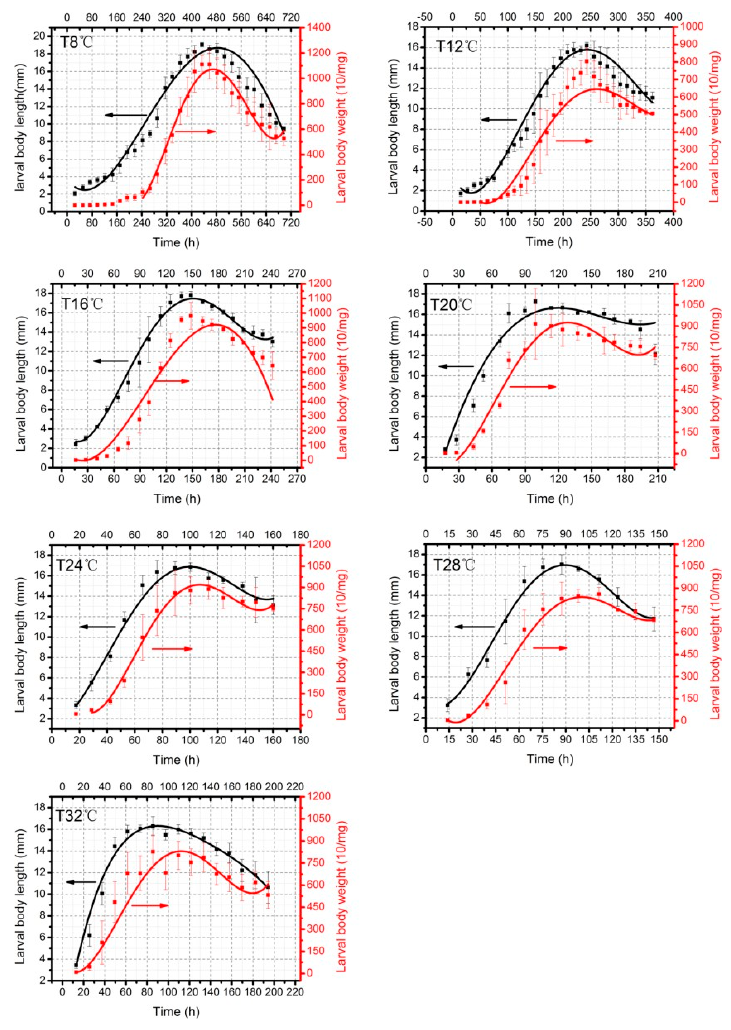
Figure 5. Changes in larval body length and weight of A. grahami at different constant temperatures. Larval body length changes were described in the left y-axis, and the larval body weight changes were shown in the right y-axis (10 larvae body weight as one unit).